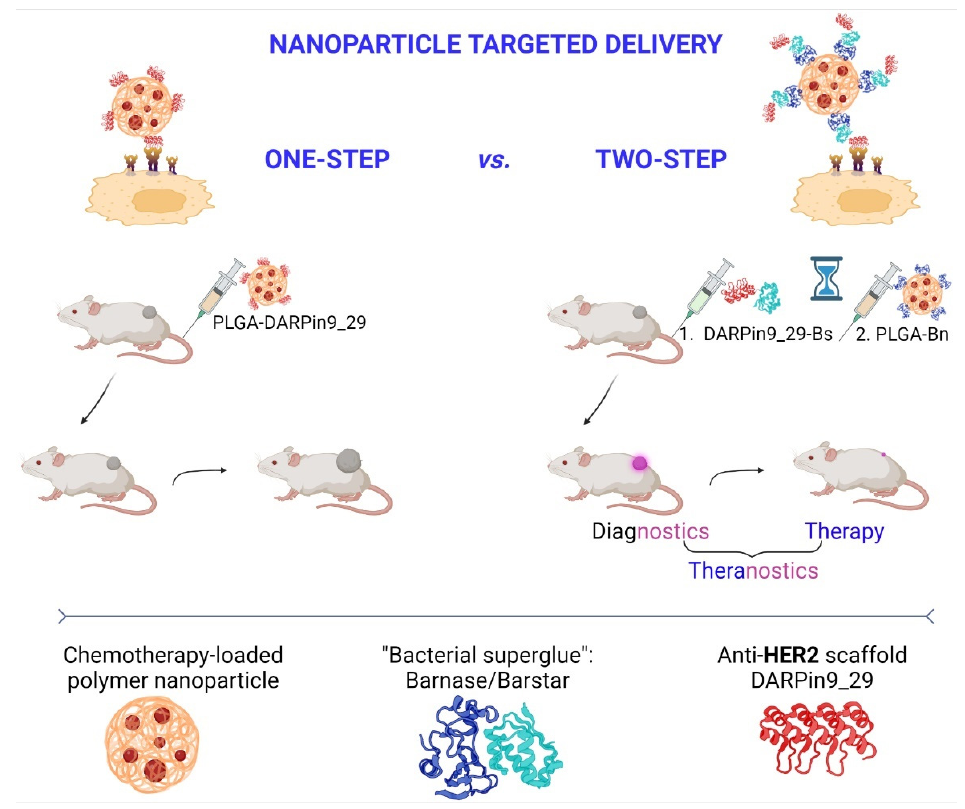
Figure 1. Two-step targeted delivery of polymer oncotheranostic nanoparticles is more effective than one-step delivery for image-guided HER2-overexpressing breast cancer treatment: scheme of the experiment.